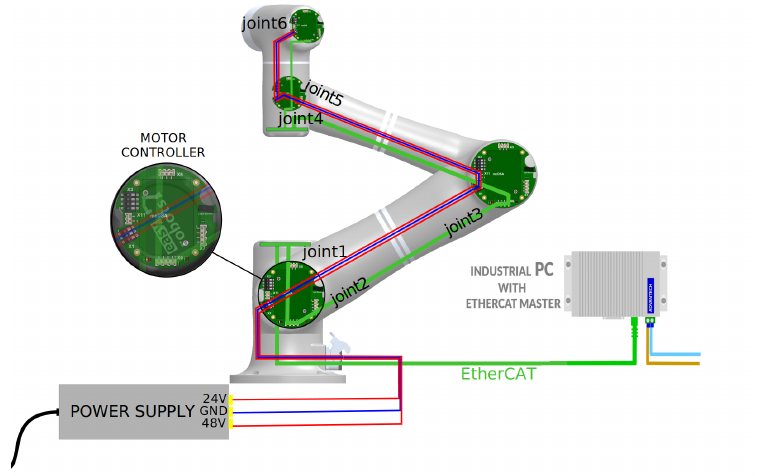
Figure 9. Graphic diagram of the basic components of the measuring system.